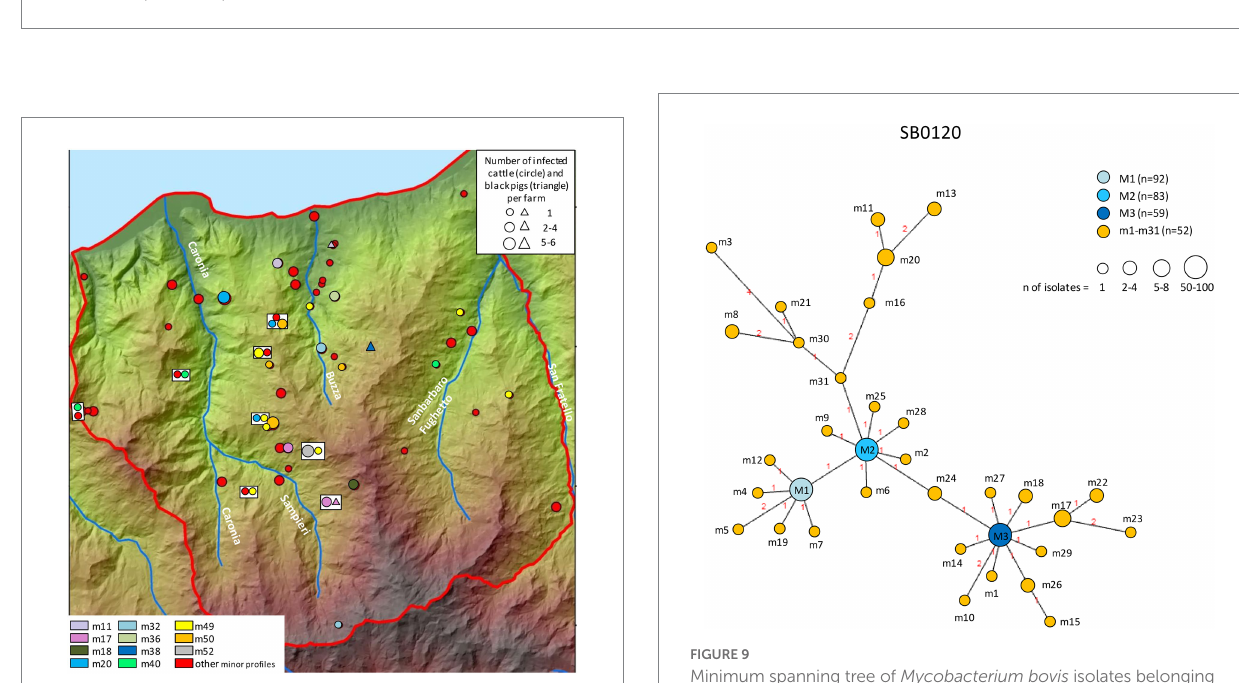
FIGURE 7 Distribution and frequency of the major genetic profiles of Mycobacterium bovis . Cattle and black pigs are marked as circles and triangles, respectively. The size of the circle and triangle symbols is proportional to the number of infected animals per herd. Symbols inside rectangles refer to the same herd. The black arrows indicate a rocky ridge. The Caronia, Sampieri, Buzza and Sanbarbaro Fughetto streams are indicated, as well as subareas H1– H8. The map was adapted from QGis.